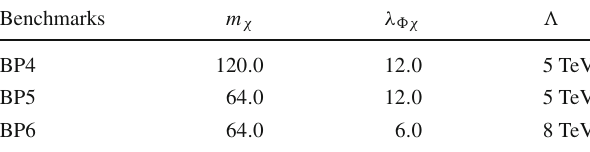
Table 2 The benchmark points for b ¯ b + / E T final state. We have chosen f 1 = f 2 = 1 for all the